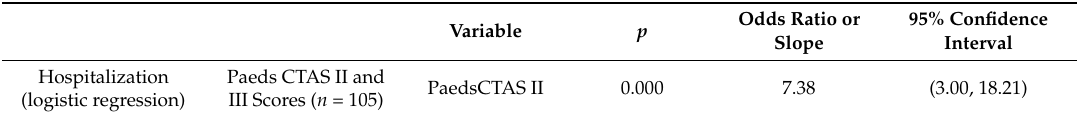
Table 1. Logistic regression modeling of hospitalization by